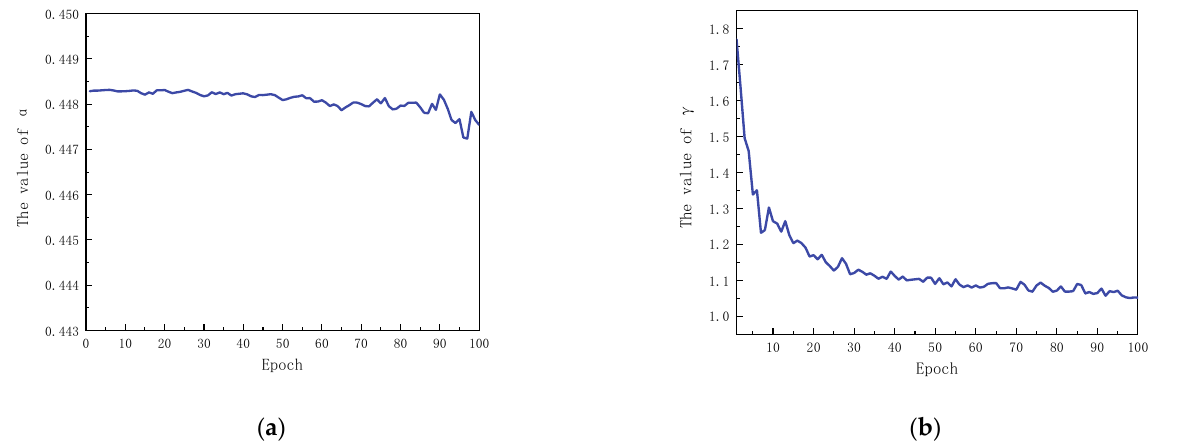
Figure 6. Numerical dynamics of α and γ . ( a ) The numerical change process of α . ( b ) The numerical change process of γ .